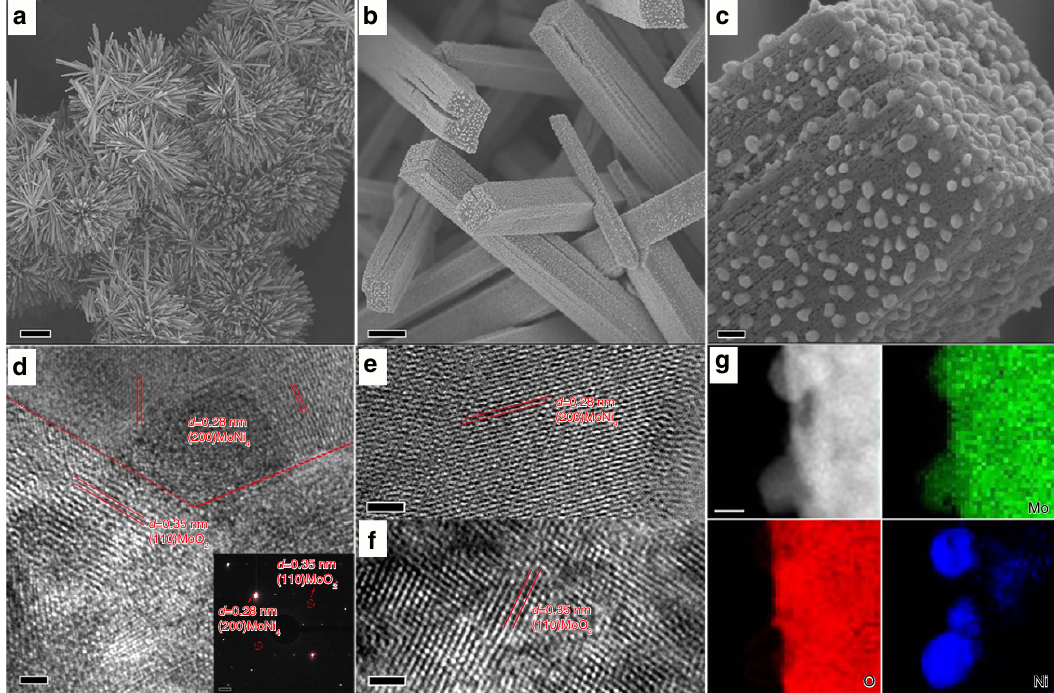
Figure 2 | Morphology and chemical composition analyses of MoNi 4 /MoO 2 @Ni. ( a – c ) Typical SEM and ( d – f ) HRTEM images of MoNi 4 /MoO 2 @Ni; ( g ) corresponding elemental mapping images of the MoNi 4 electrocatalyst and the MoO 2 cuboids. The inset image in d is the related selected-area electron diffraction pattern of the MoNi 4 electrocatalyst and the MoO 2 cuboids. Scale bars, ( a ) 20 m m; ( b ) 1 m m; ( c ) 100nm; ( d – f ) 2nm; inset in d , 1 1/nm; ( g )